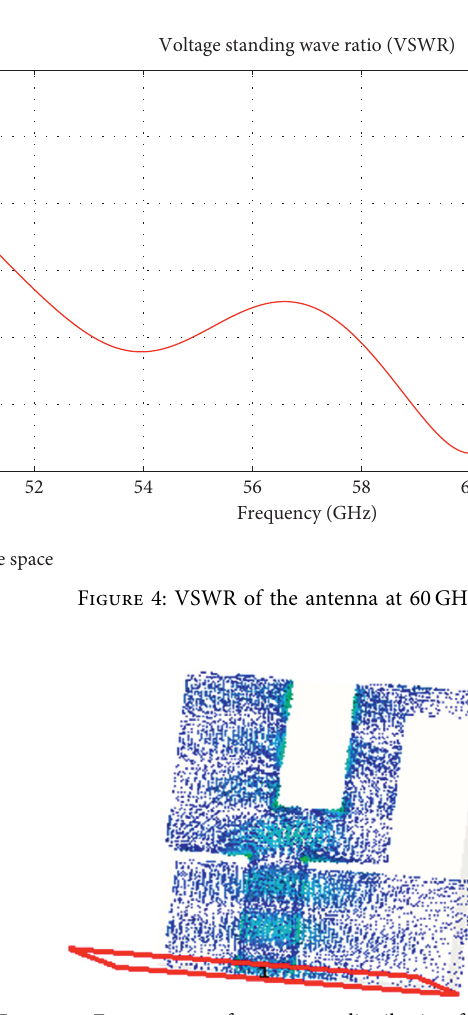
Figure 5: Free-space surface current distribution for